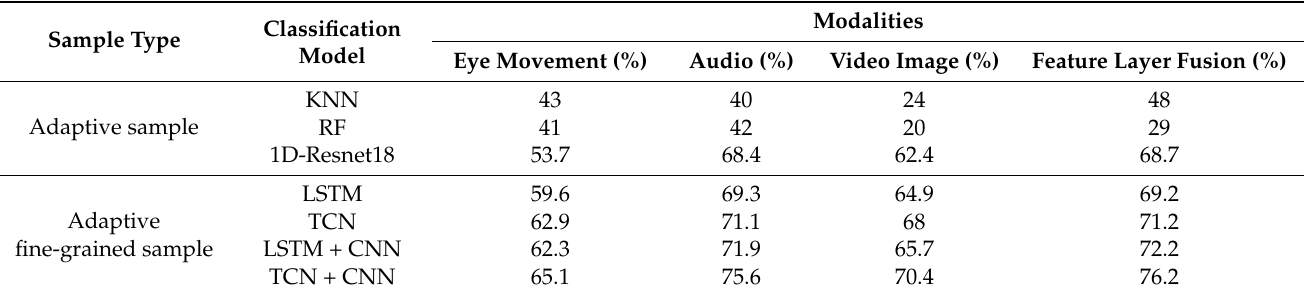
Table 4. Recognition accuracy for different models with adaptive samples (n = 30) and fine- grained samples.